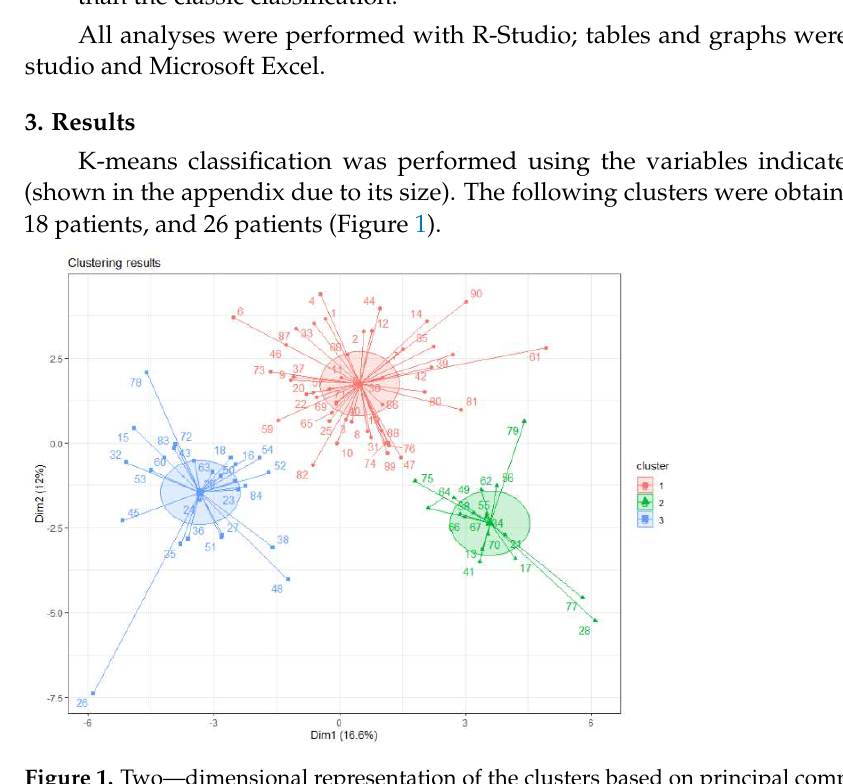
Figure 1. Two−dimensional representation of the clusters based on principal component analyses. Figure 1. Two—dimensional representation of the clusters based on principal component